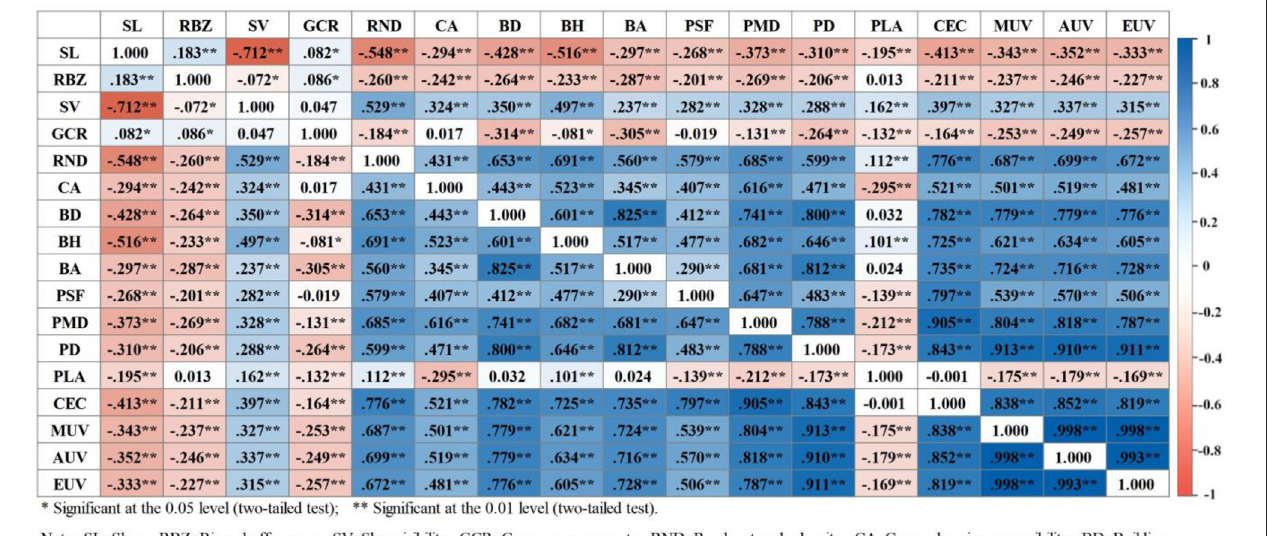
TABLE 4 The OLS regression model between urban vitality and 13 environmental factors.